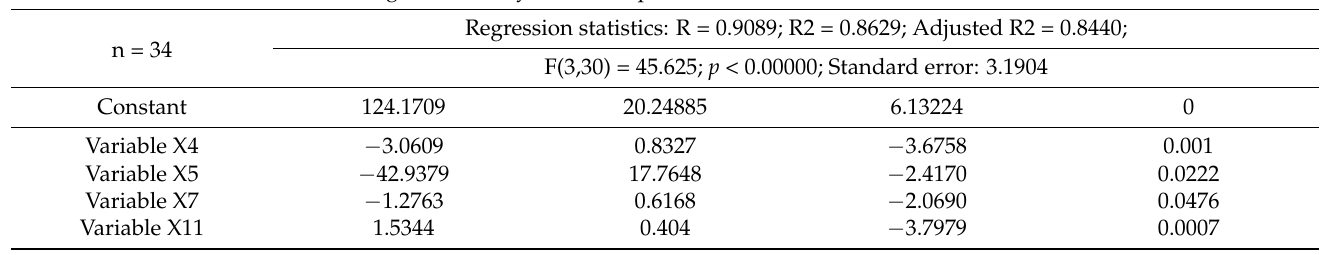
Figure 3. Fuel poverty rate versus social benefits to households in Poland in 2004–mid ‐ 2021.